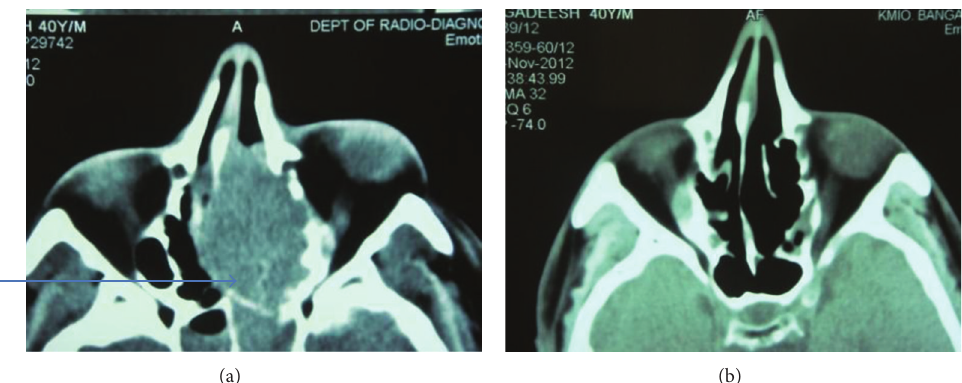
Figure 1: Computed tomography (CT) of paranasal sinuses and orbit showing mass (arrow) occupying the entire left ethmoid and sphenoid sinus extending into left nasal cavity causing erosion of nasal septum, extending into orbit and intracranial extension into basifrontal area (before chemoradiation and after chemoradiation).